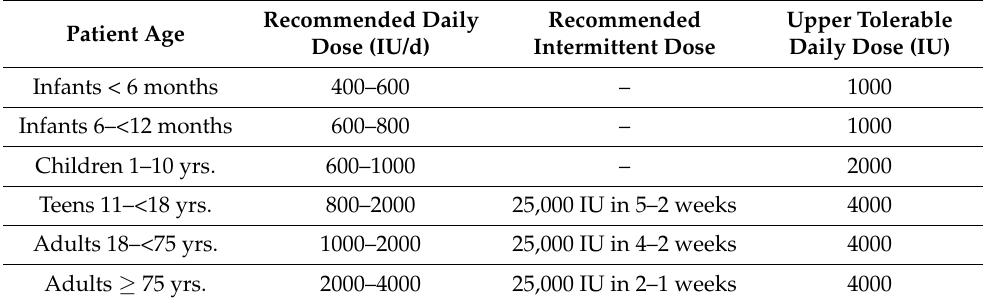
Table 3. Vitamin D prophylactic doses.